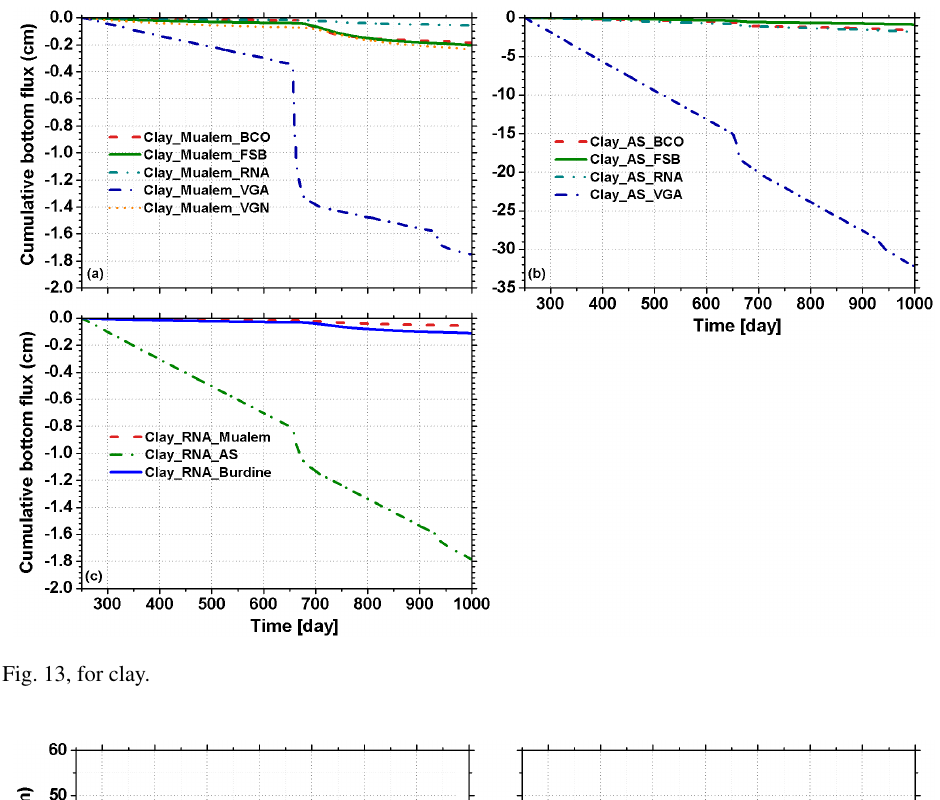
Figure 16. As in Fig. 13, for clay.